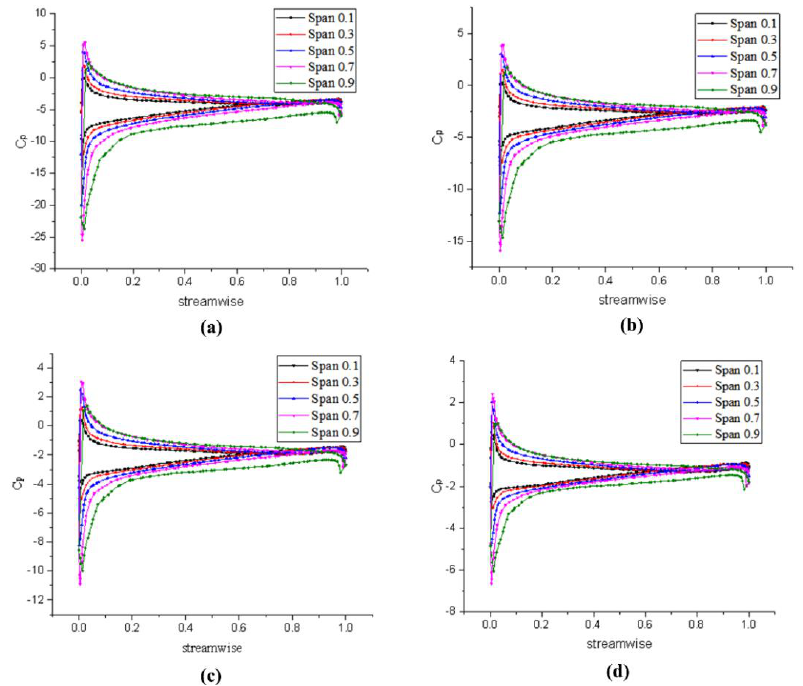
Figure 17. Tangential pressure distribution of the rotor designed by lifting-line method: ( a ) v = 7 m/s ( J = 0.78), ( b ) v = 8.5 m/s ( J = 0.95), ( c ) v = 10 m/s ( J = 1.12), and ( d ) v = 11.5 m/s ( J = 1.28).